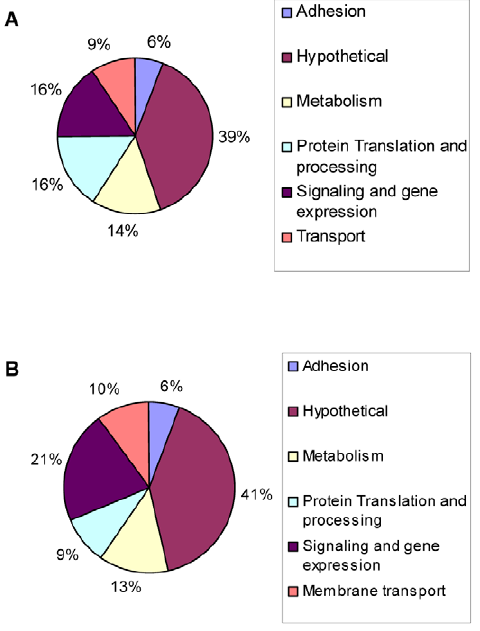
Figure 2. Genes modulated during alkaline pH stress in wild- type Toxoplasma . Microarray analysis was performed on wild-type parasites incubated in HFFs cells under normal culture conditions (pH 7.0) or alkaline conditions (pH 8.2) for three days. Pie chart displays the GO categories of genes reported to be (A) up-regulated or (B) down-regulated in response to alkaline conditions (p , 0.001).